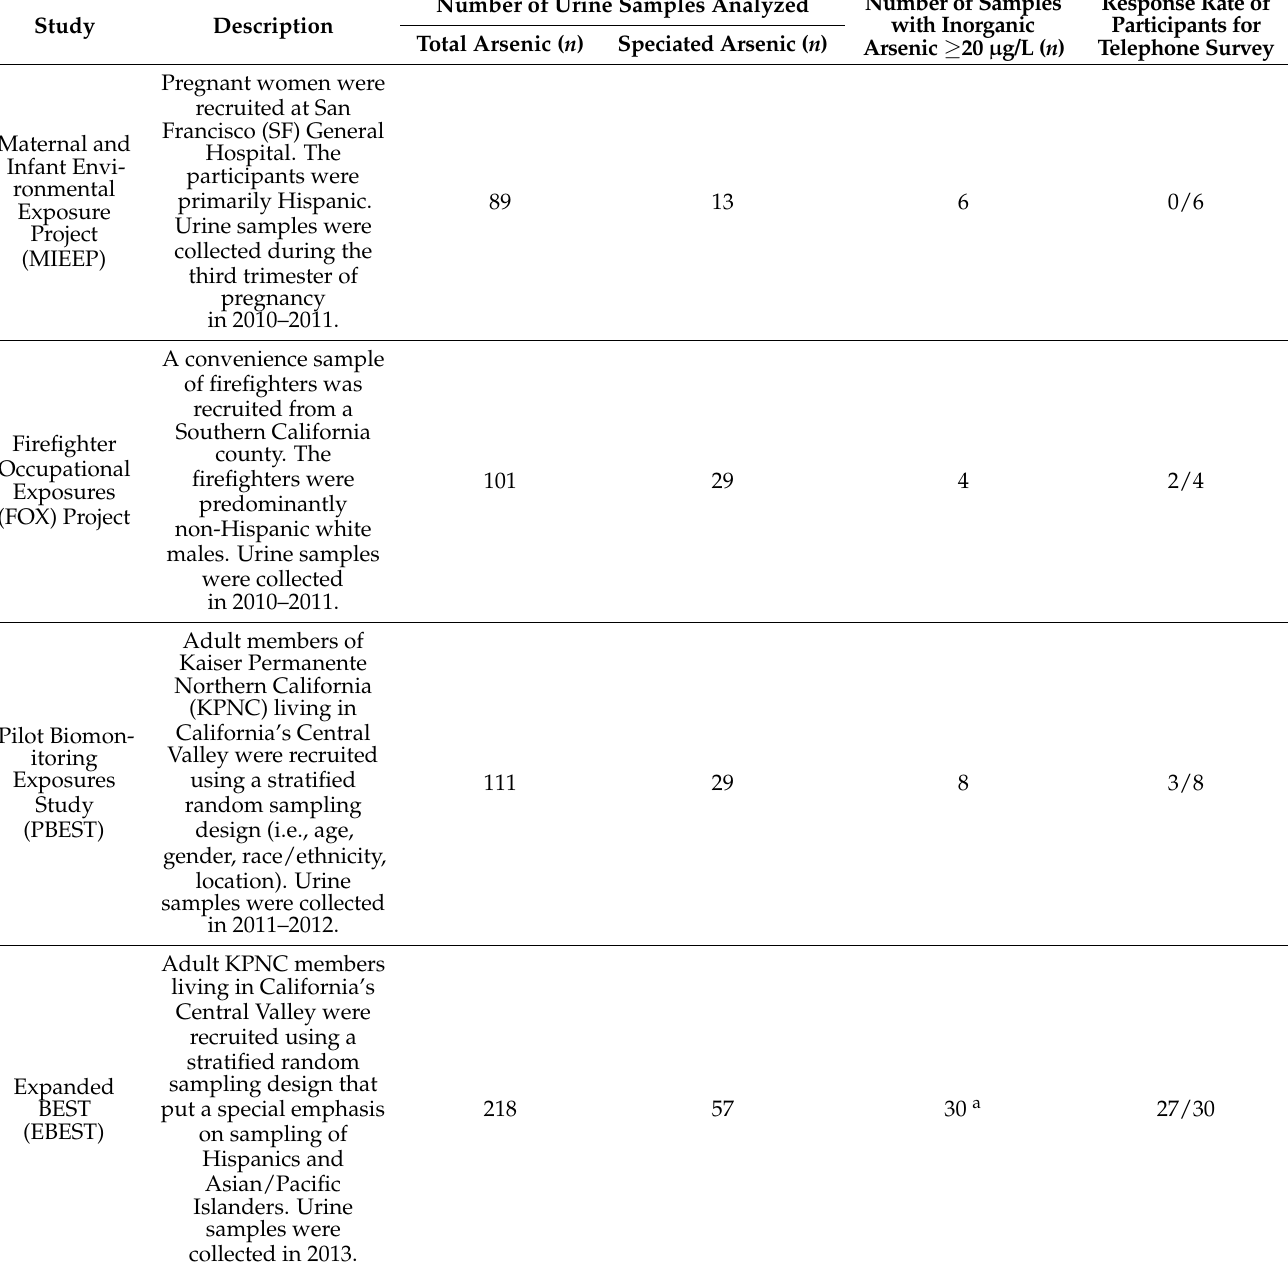
Table 1. Overview of four Biomonitoring California